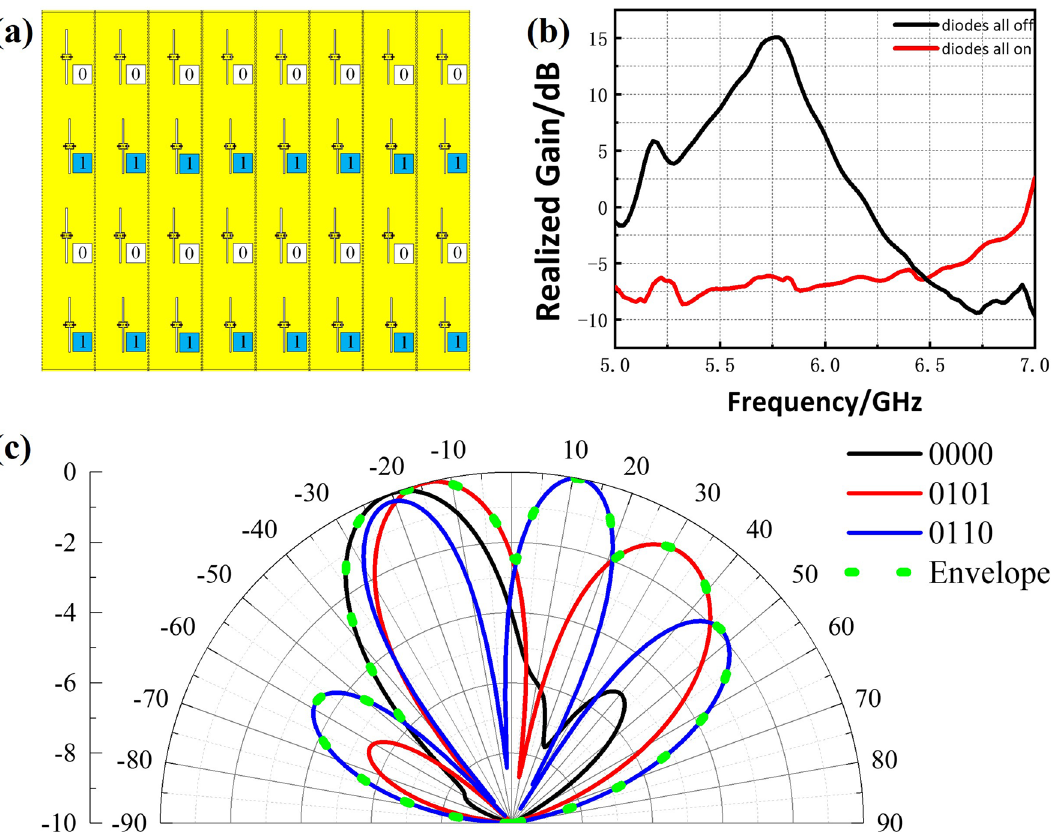
Figure 7. ( a ) Binary coding for bias voltage distributions (‘0101’ state as example). ( b ) Simulated realized gain of both ‘0000’ and ‘1111’ states. ( c ) Simulated far field normalized radiation patterns of the tunable designed SIW-slot antenna array in several on/off states of diodes ( ϕ = 90